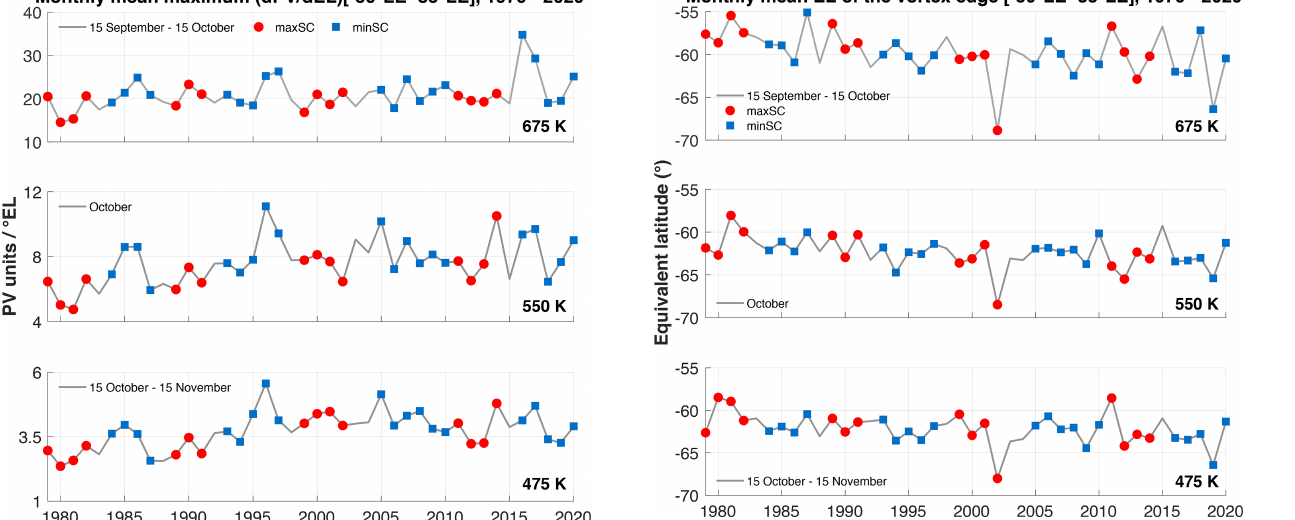
Figure 7. Interannual evolution of the maximum vortex edge inten- sity for the period 1979–2020, averaged over 15 September–15 Oc- tober for 675K, October for 550K, and 15 October–15 November for 475K. The maxSC years are represented by red circles and the minSC years by blue squares.